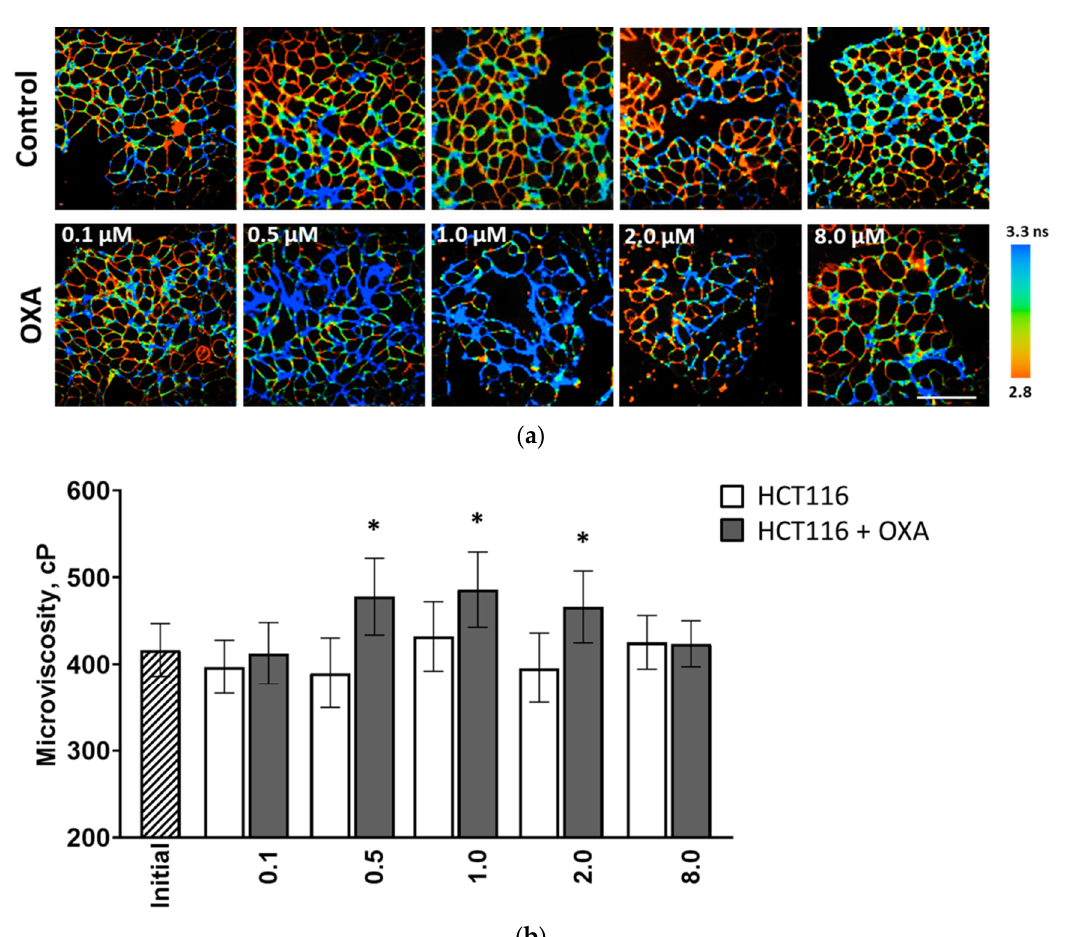
Figure 1. Plasma membrane viscosity in cultured HCT116 cells during development of chemoresistance to oxaliplatin. ( a ) Representative FLIM images of parental cells (upper row) and cells adapted to the indicated drug doses (bottom row). Oxaliplatin was removed from the culture medium 48 h prior to the viscosity imaging. BODIPY 2 (4.5 μ M) was used as a viscosity-sensitive probe. Ex. 850 nm, reg. 500–550 nm. Molecular rotor demonstrated a monoexponential fluorescence decay in plasma membrane. Bar is 40 μ m, applicable to all images. ( b ) Quantification of viscosity of plasma membranes in HCT116 cells. Mean ± SD, n = 20–30 cells for each drug dose. Statistical significance was determined by ANOVA with Bonferroni post-hoc test. *, p ≤ 0.05 with control.